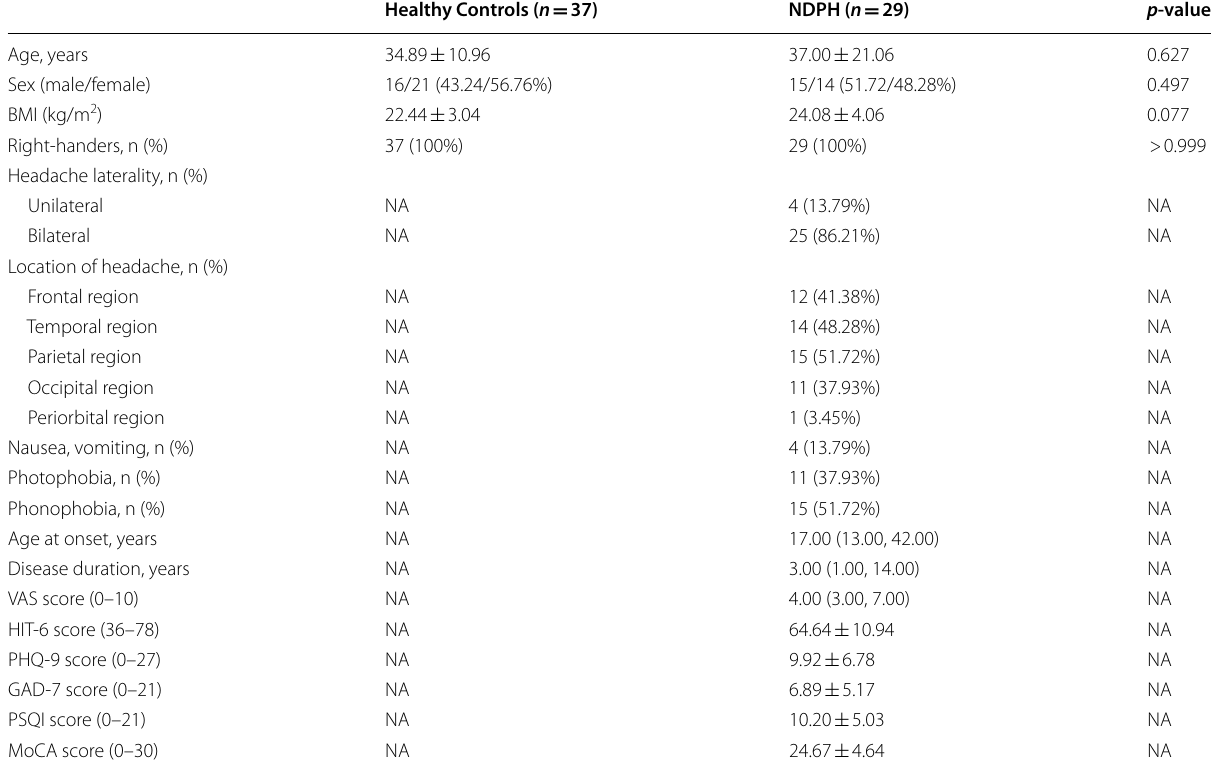
Table 1 Participants’ demographics and clinical